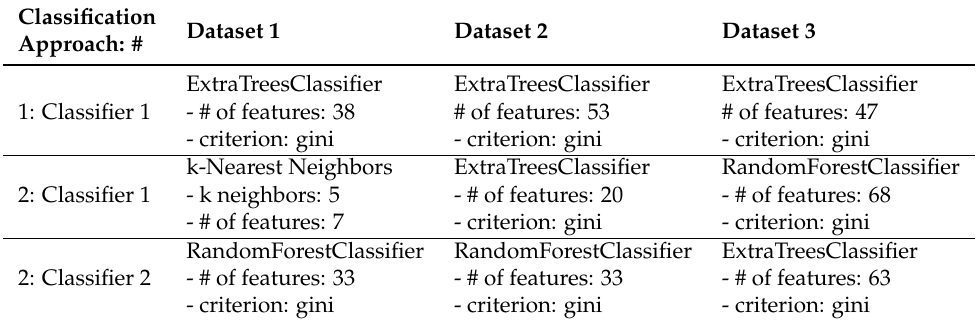
Table 8. Classification